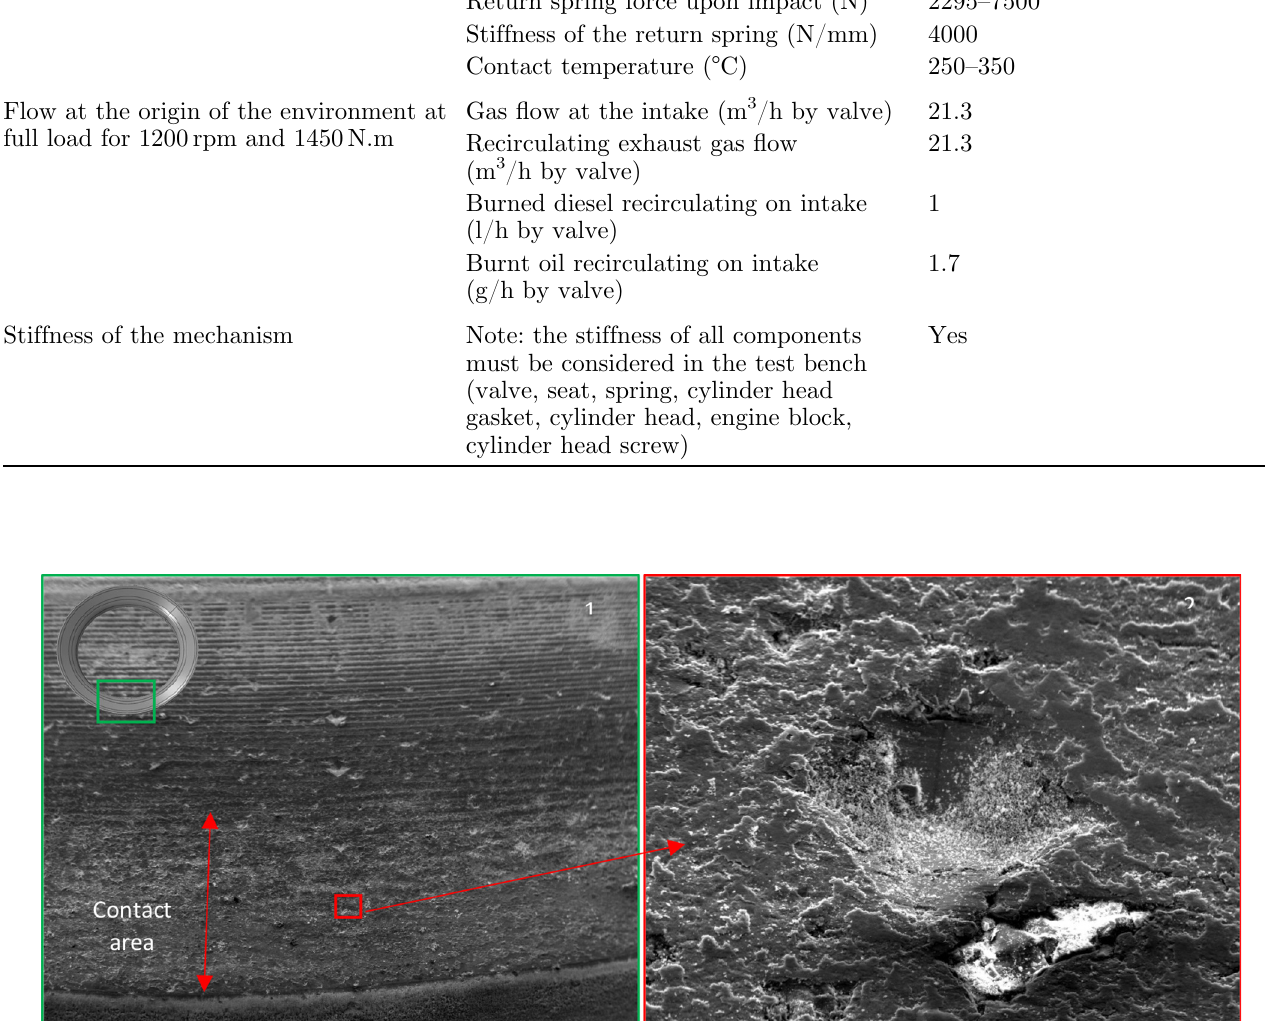
Table 5. Parameters of tests carried out on the “ Cube ” . Valve dynamics characteristic for full engine load at 1200 rpm and 1450 N.m